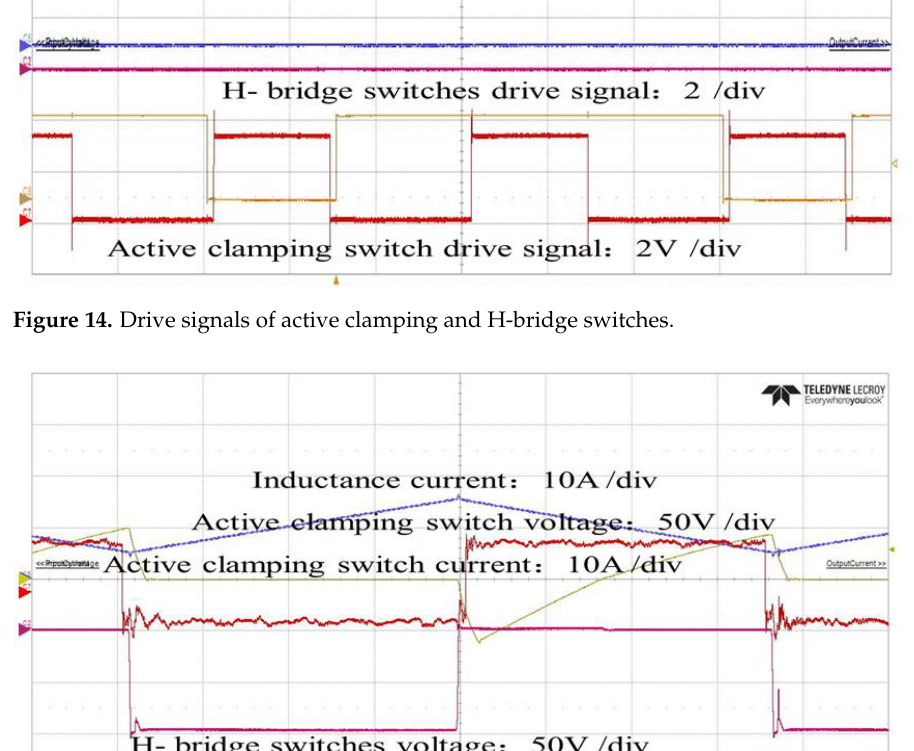
Figure 15. Active clamping switch ZVS process of DC/DC module.